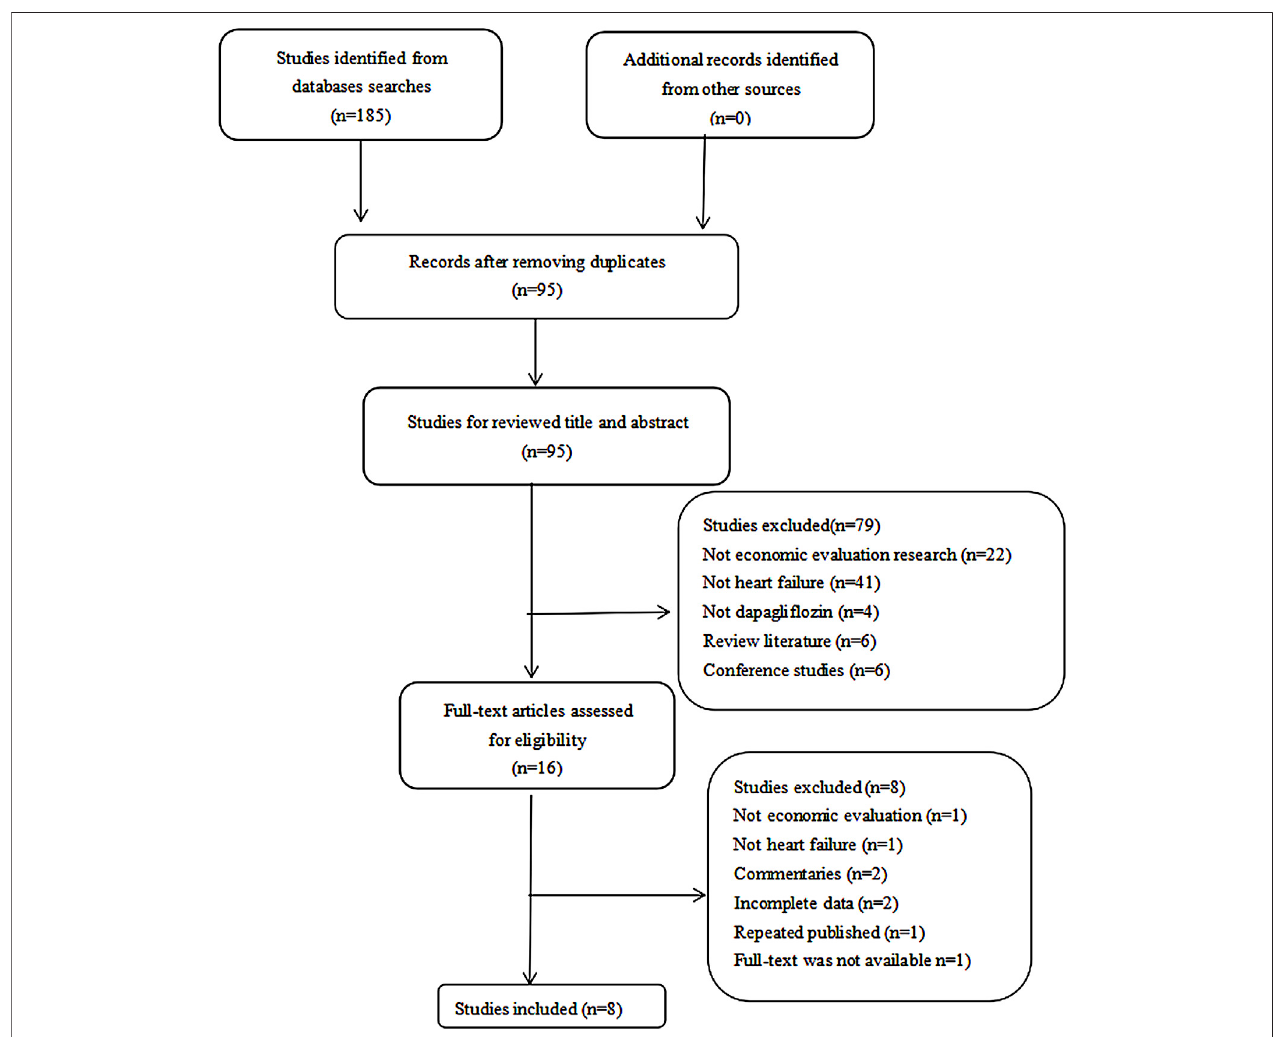
FIGURE 1 | Diagram showing inclusion and exclusion of